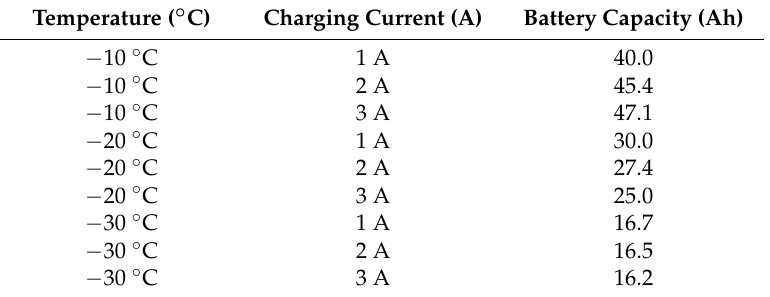
Table 4. Battery-capacity calculation results of the charging experiment.